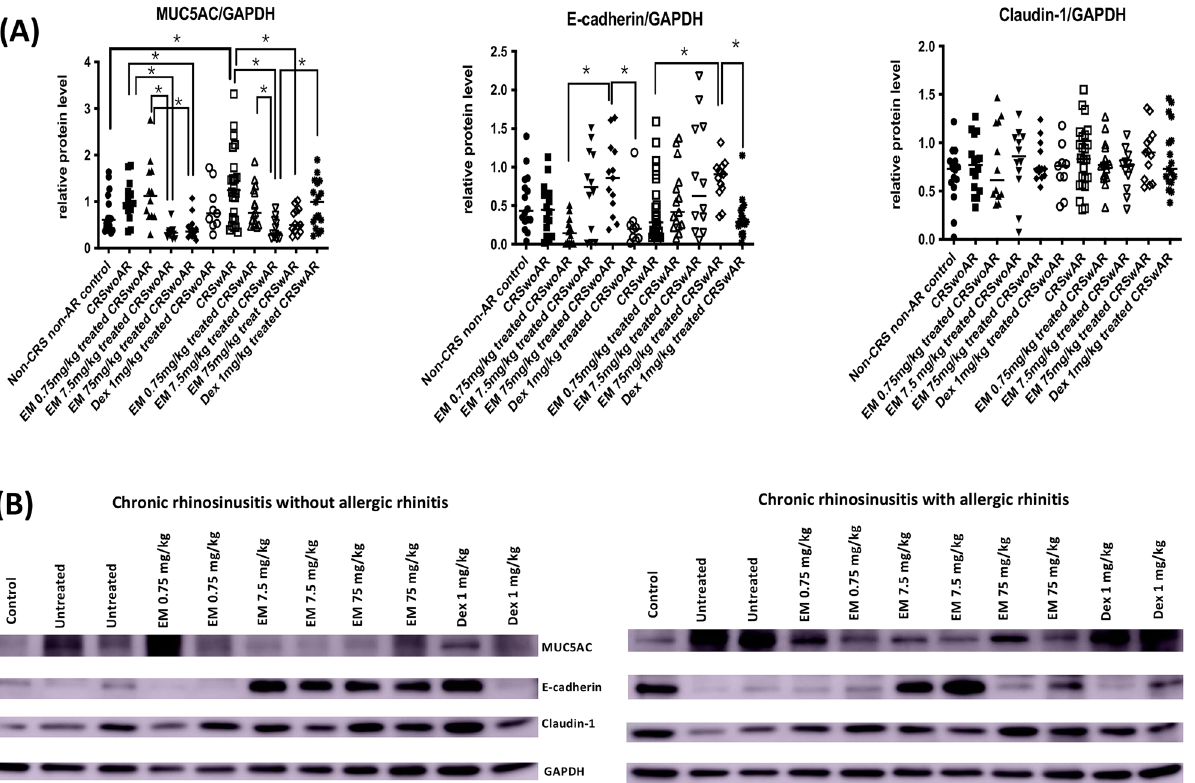
Figure 6. ( A ) Relative protein expressions of MUC5AC, e-cadherin, and claudin-1 in nasal mucosa of experimental mice ( B ) Representative results of western blotting. Because of limited amount of nasal